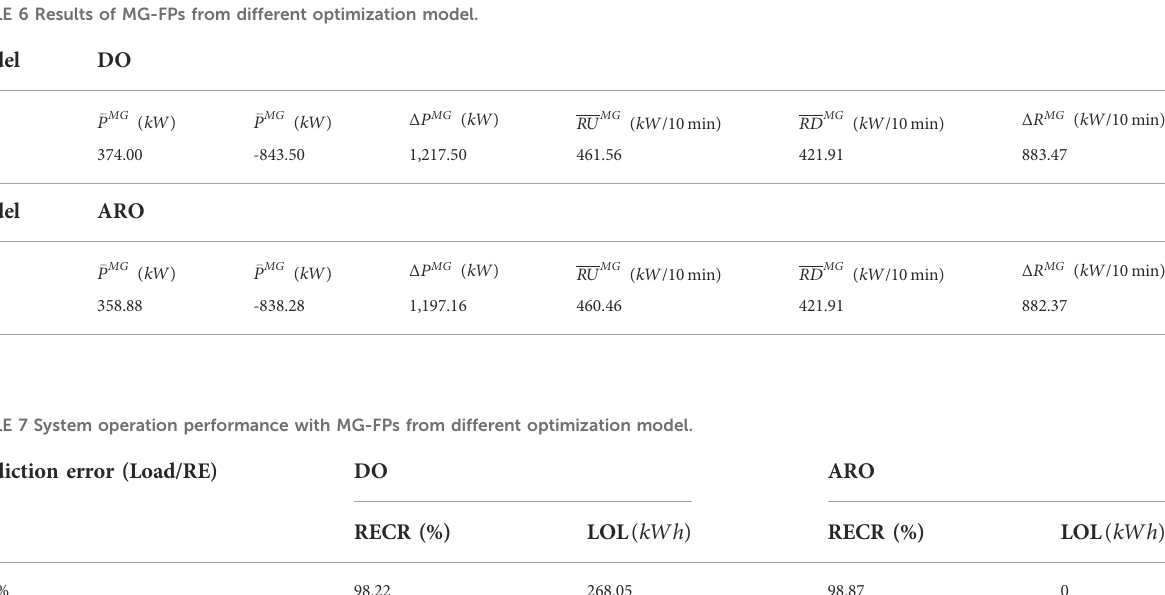
TABLE 6 Results of MG-FPs from different optimization model. Model